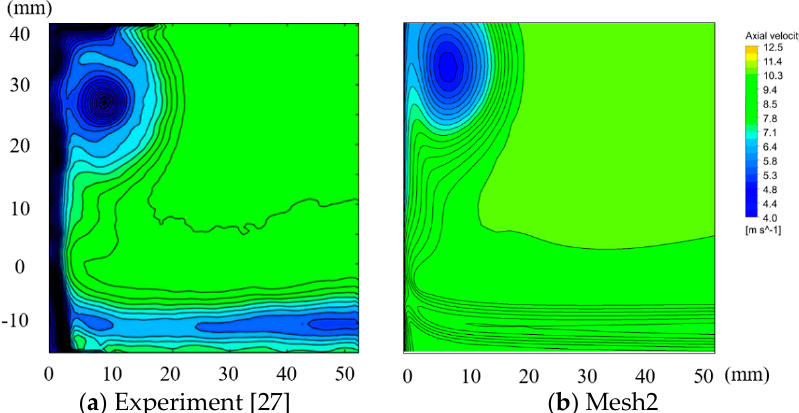
Figure 3. Comparison of the axial velocity contour at cut-plane of z / c = 1 between experiment [27] and numerical simulation. ( a ) Experimental results. ( b ) Numerical results.